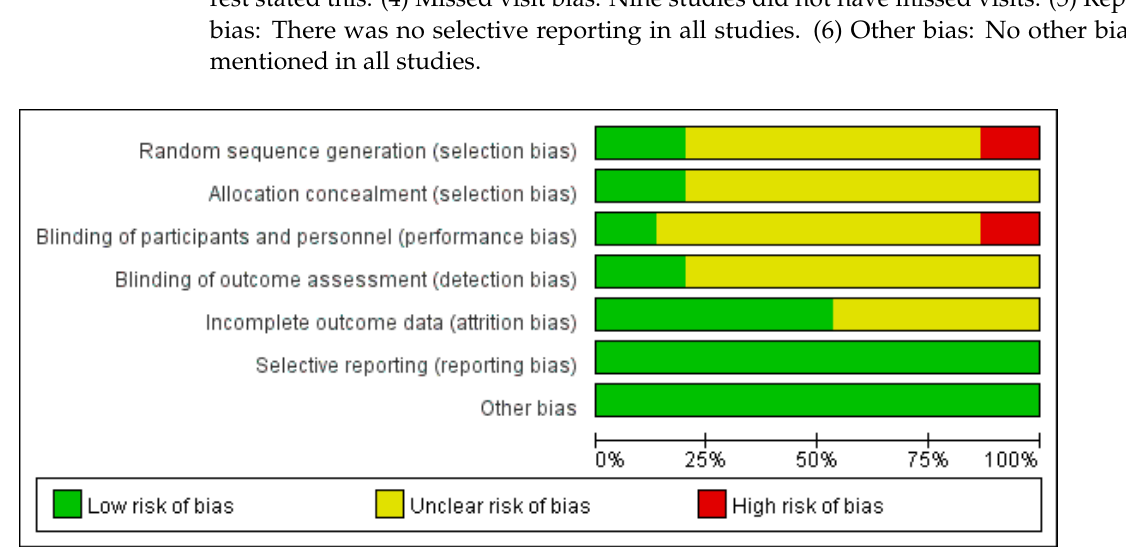
Figure 2. “Risk of bias” graph of included studies.